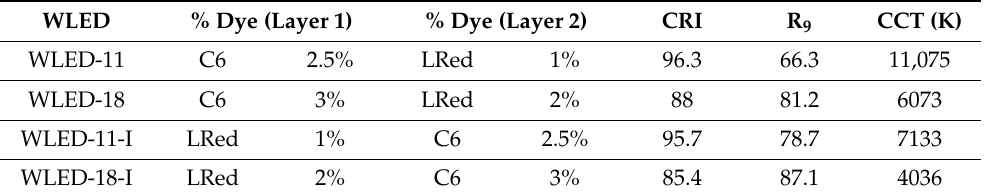
Table 4. Selection of the best WLEDs and optical